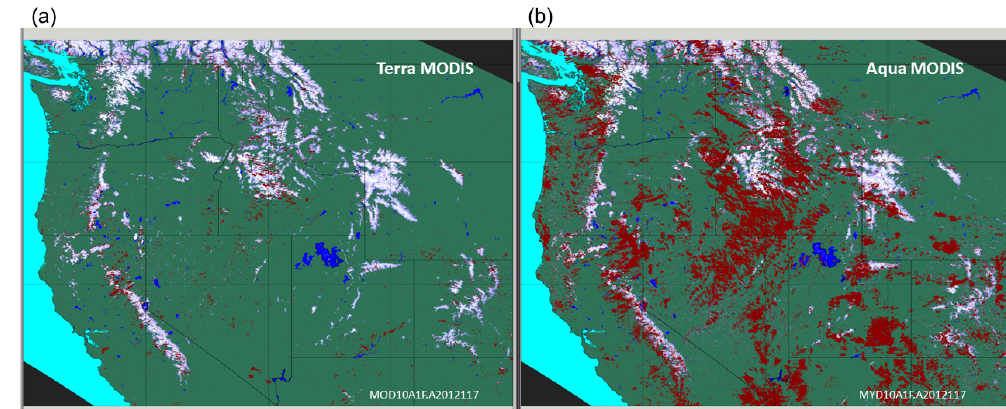
Figure 11. Terra MODIS (a) and Aqua MODIS (b) cloud-gap-filled (CGF) snow-cover maps from 26 April 2012. Note that there are red pixels on both snow maps indicating “no decision” by the algorithm; however, there are many more red pixels on the Aqua MODIS snow map, primarily due to the inability of the Aqua MODIS cloud mask to identify large areas of cloud cover as “certain cloud”. The location of this western US study area is shown in Fig. 1. The base map was obtained from Interactive Data Language (IDL) software that uses Natural Earth raster + vector map data, which are in the public